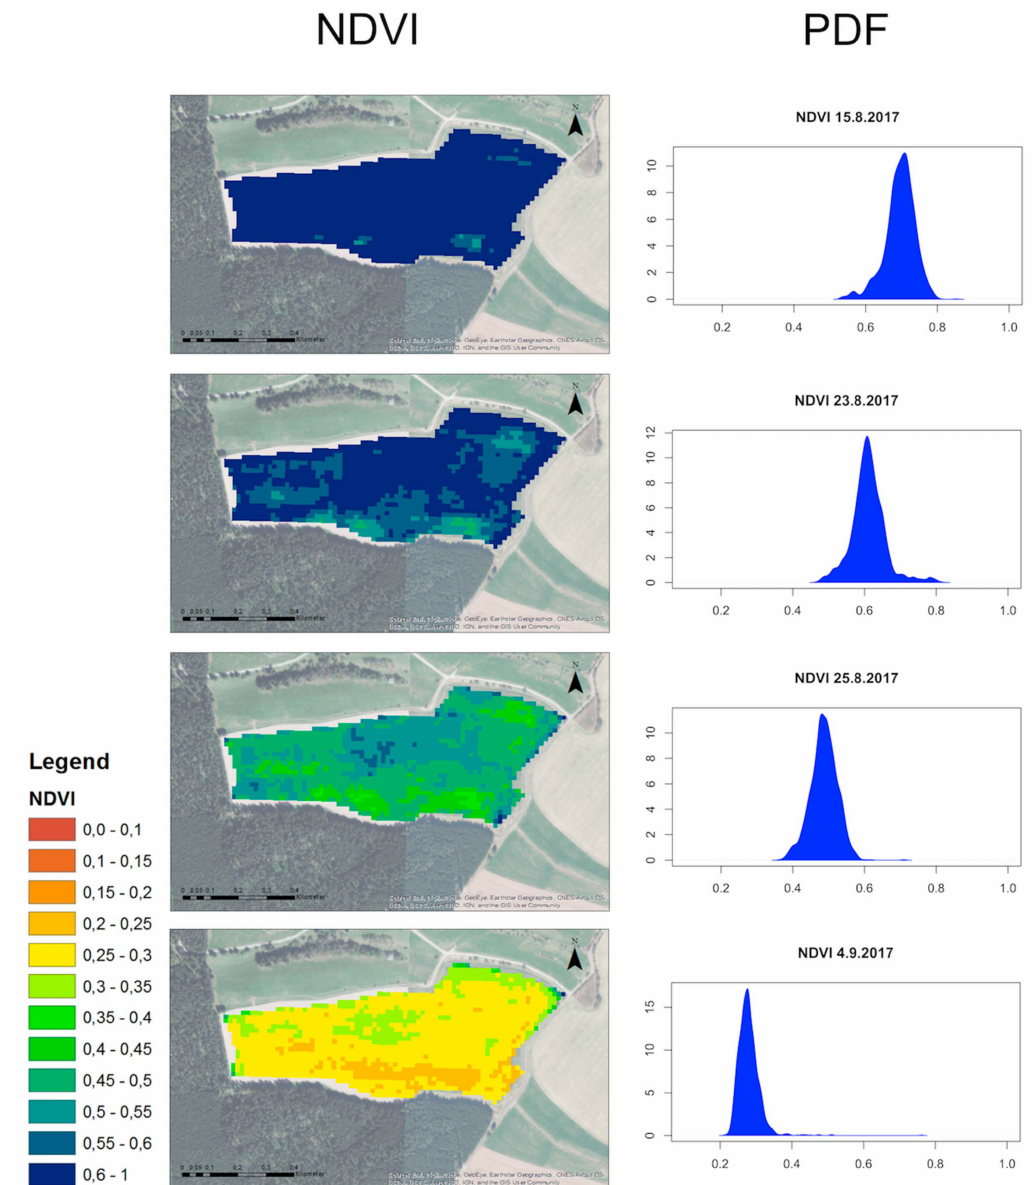
Figure 4. Visualization of spatio-temporal dynamic of NDVI values for test site Langer Acker and appropriate probability density